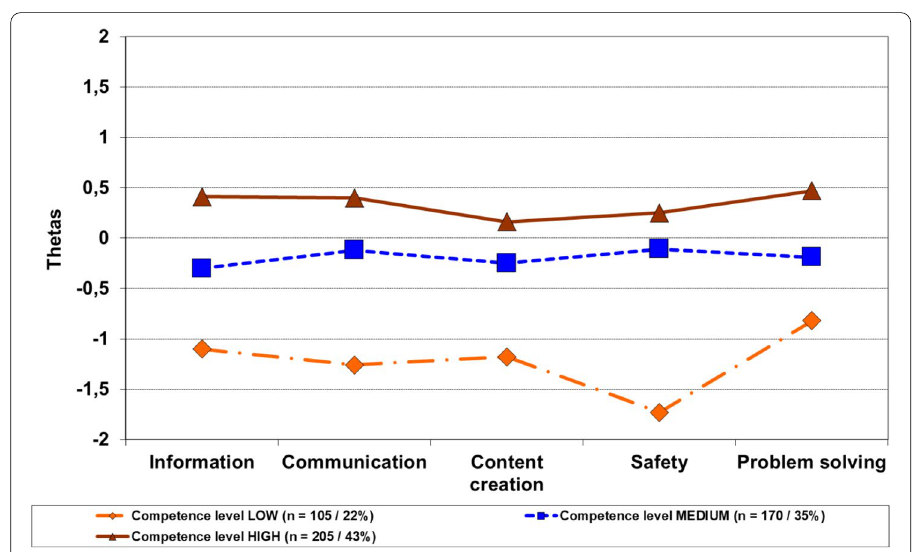
Fig. 3 Latent profile analysis of digital competences with three profile